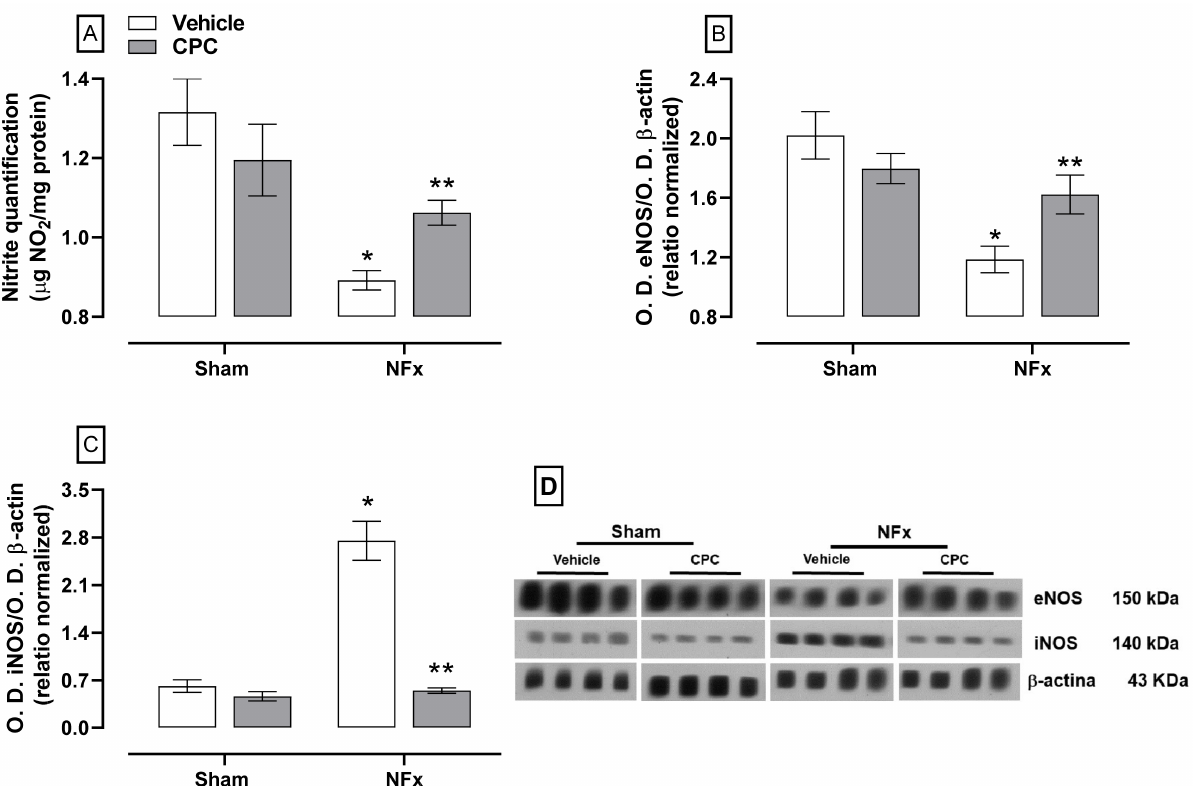
Figure 6. Effect of CPC on nitrite quantification ( A ), eNOS ( B ) and iNOS ( C ) expression in the aorta. ( D ) Blot of the protein expression. Values represent the mean ± SEM. (*) p < 0.05 com- pared to the sham + vehicle at the same concentration. (**) p < 0.05 compared to the NFx + vehicle. Two-way ANOVA and SNK post hoc